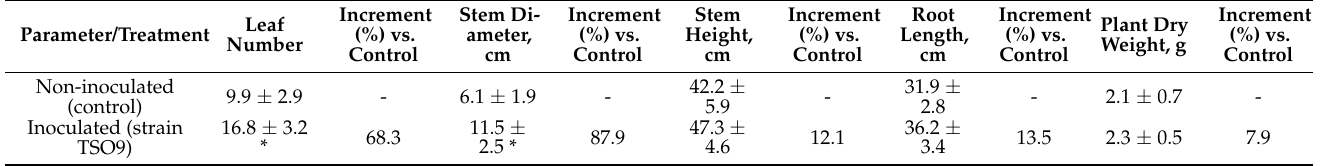
(Table 1). Finally, the capacity of strain TSO9 for siderophore and IAA production, as well as biocontrol against B. sorokiniana TPQ3, were not observed. Table 1. Wheat plants’ growth promotion by the inoculation of the strain TSO9.